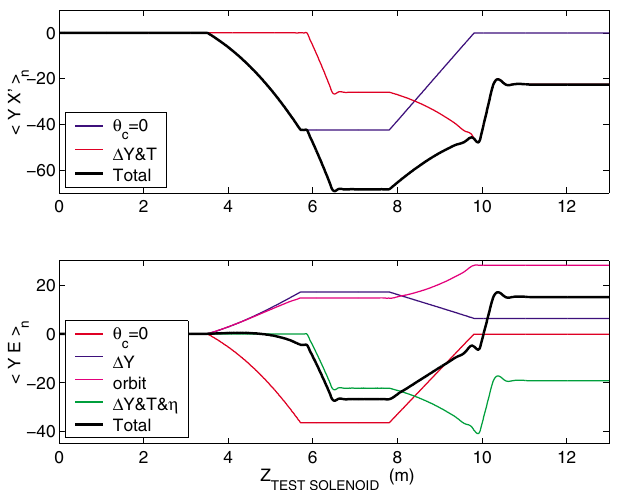
FIG. 12. (Color) Contributions of different terms to the coupling h yx 0 i and vertical dispersion h yE i for the test solenoid placed on the detector axis, based on analytic calculation. Coupling (top plot) includes a term independent of crossing angle (blue line) and a term from the orbit kicks and the second order matrix (red line). Dispersion (bottom plot) includes contribution from the angle independent coupling (red line), and three additional terms due to the energy dependence of the kicks (blue line), to the vertical offset in the quadrupoles (magenta line), and to the second order matrix, horizontal dispersion and orbit kick (green line). IP is at z (cid:3) 0 m